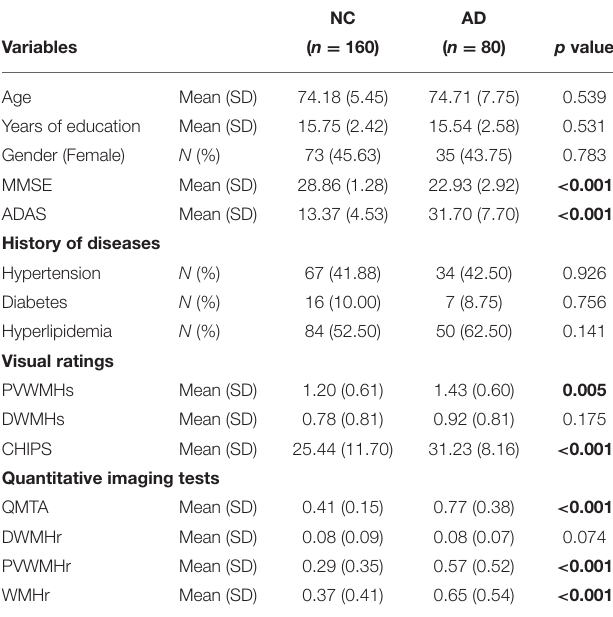
TABLE 2 | Demographic statistics and imaging-based quantifiers of NC and AD